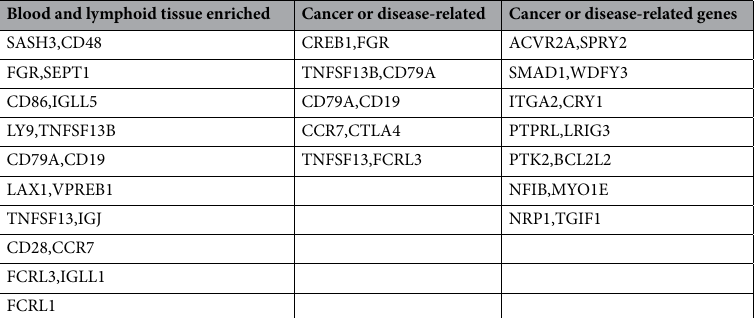
Blood and lymphoid tissue enriched Cancer or disease-related Cancer or disease-related